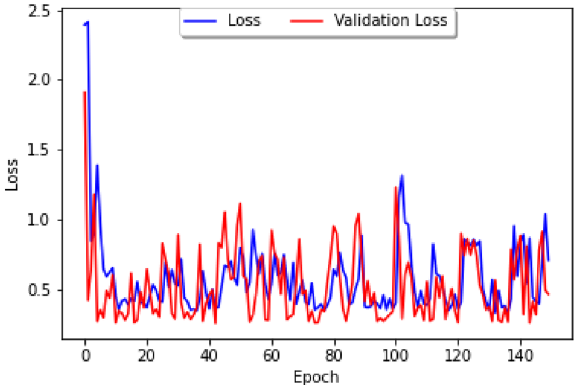
Figure 17. Loss curve for Colombia.